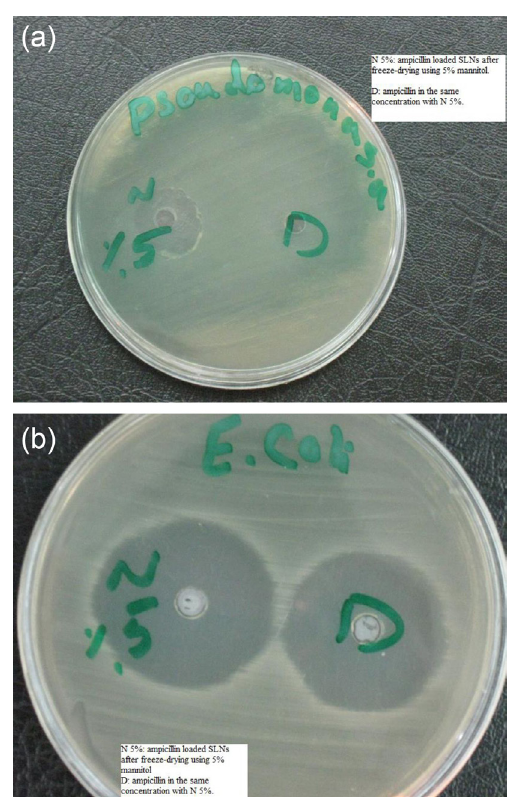
FIGURE 4 - Photographs of the zone of inhibition produced by free ampicillin and its SLNs in freeze-dried SLNs against P. aeruginosa (a) and E. coli (b).